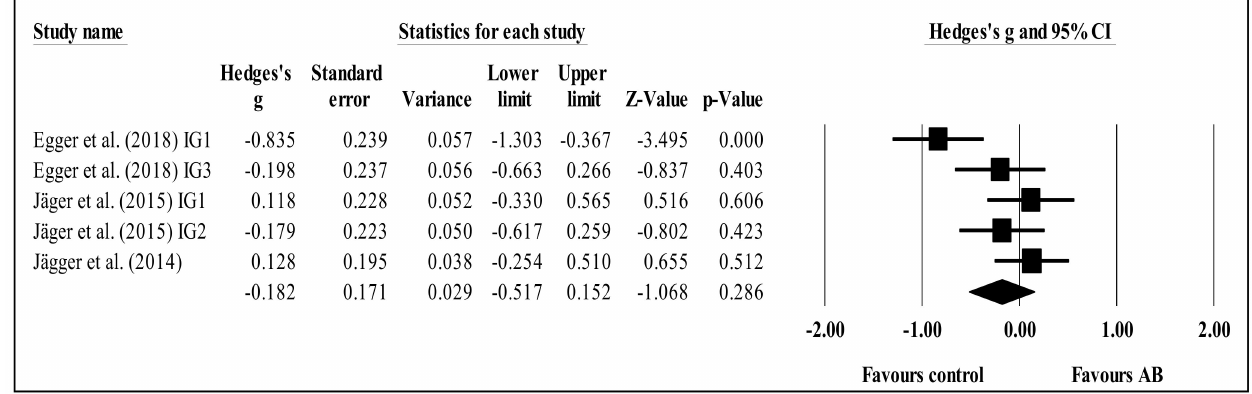
Figure 5. Forest plot of changes in shifting in school-age students participating in active breaks (AB) compared to controls. Values shown are effect sizes (Hedges’s g) with 95% confidence intervals (CI). The size of the plotted squares reflects the statistical weight of each study. The black diamond reflects the overall result. This trend is not statistically significant. IG: intervention